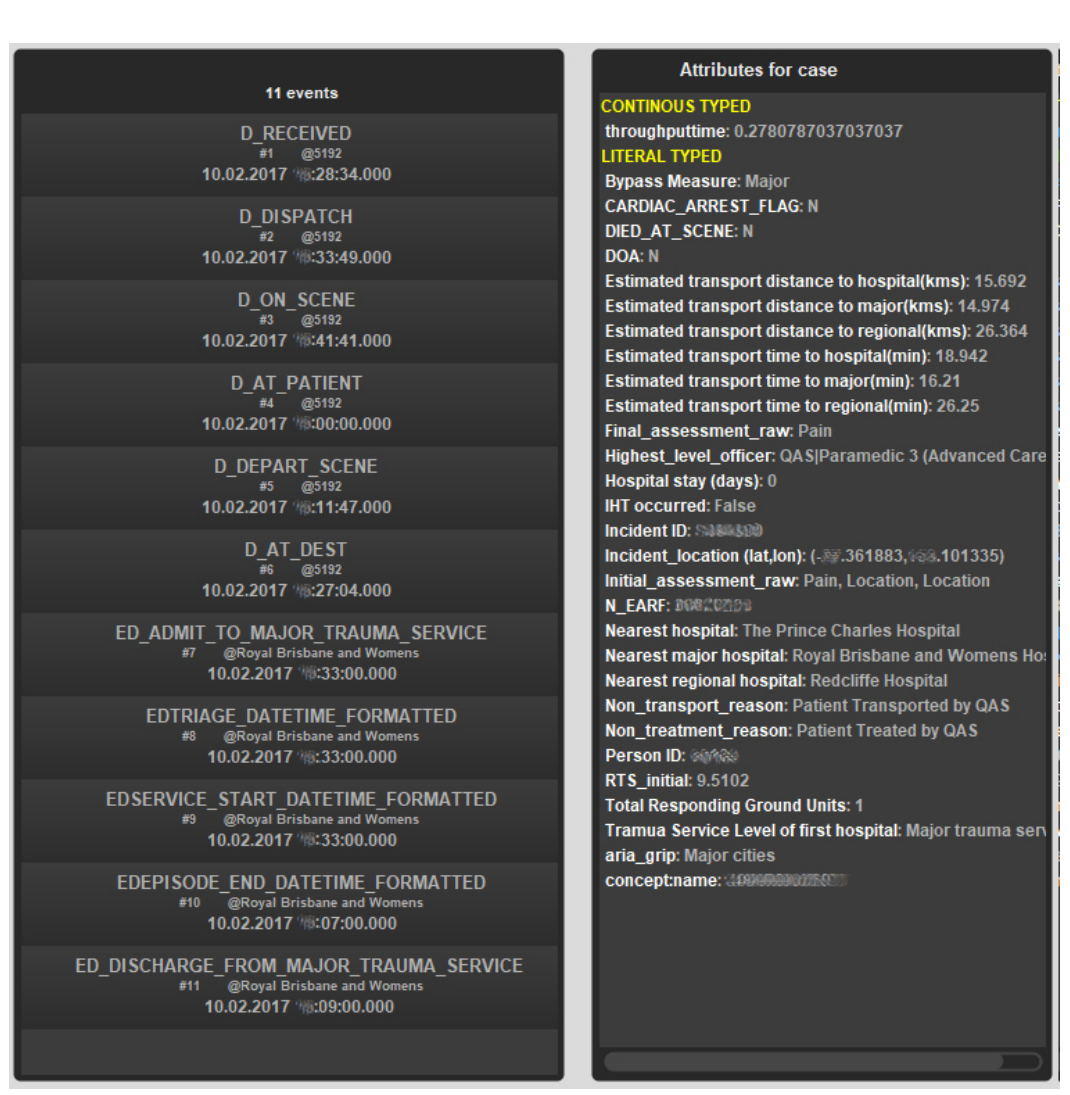
Figure 3. Example case record—with case attributes (identifiers deliberately